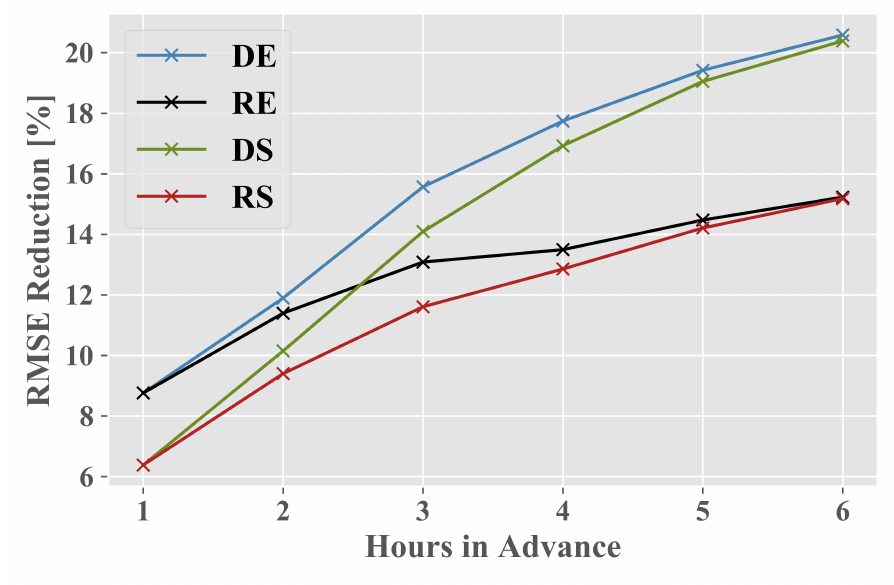
Figure 7. Similar to Figure 4 except data are taken from the SGP C1